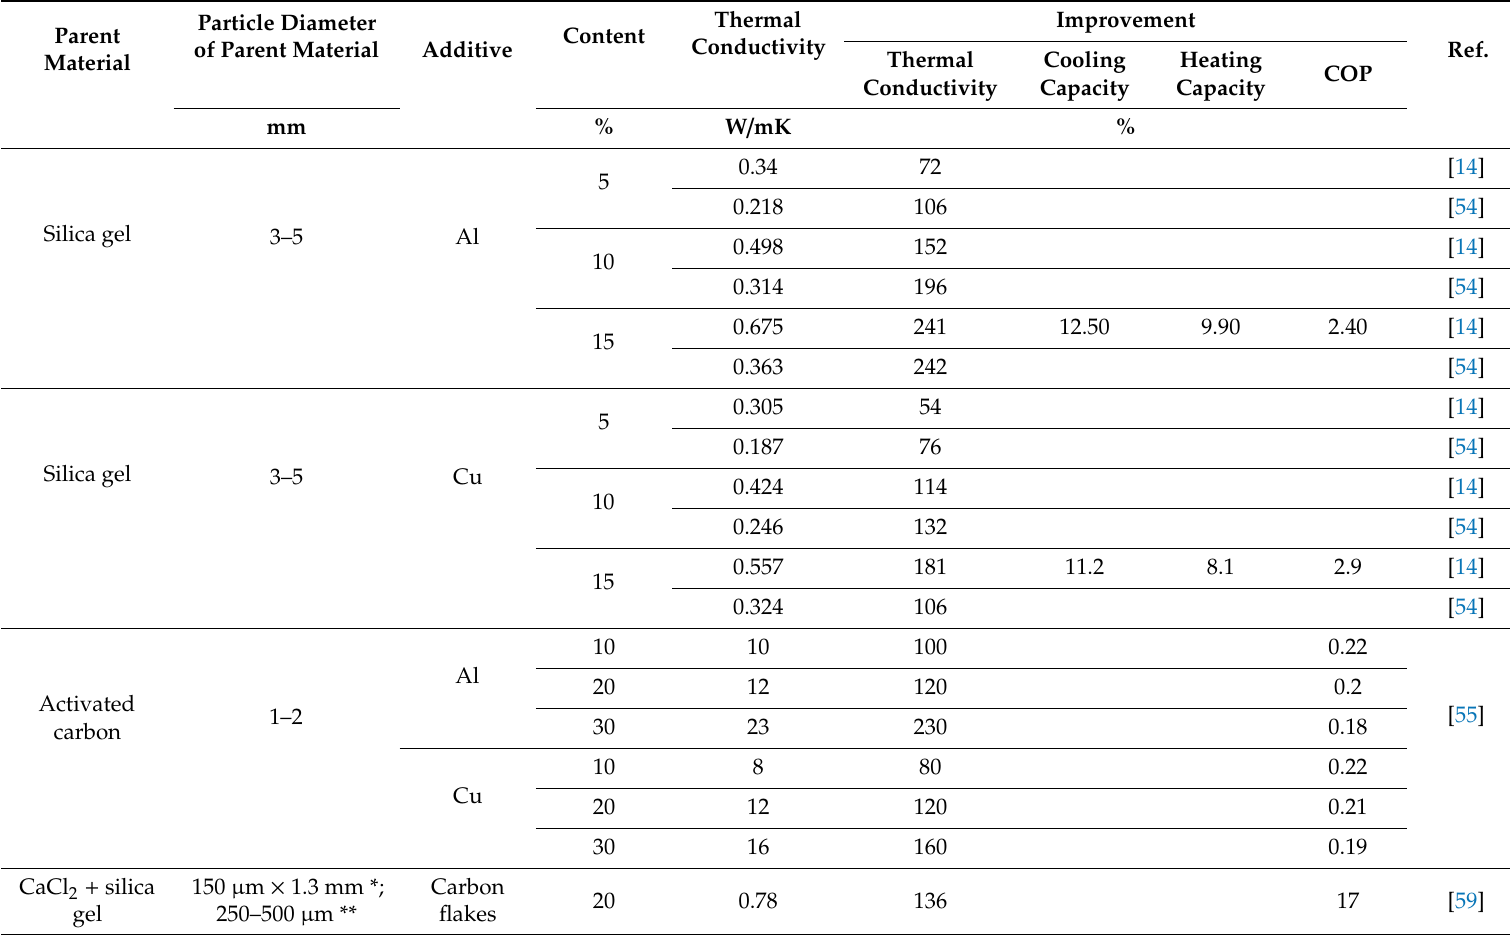
Table 1. Comparison of thermal conductivity